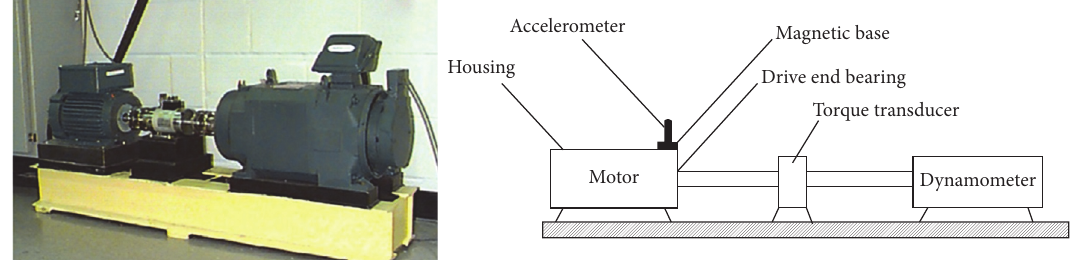
Figure 5: The bearing experimental system.